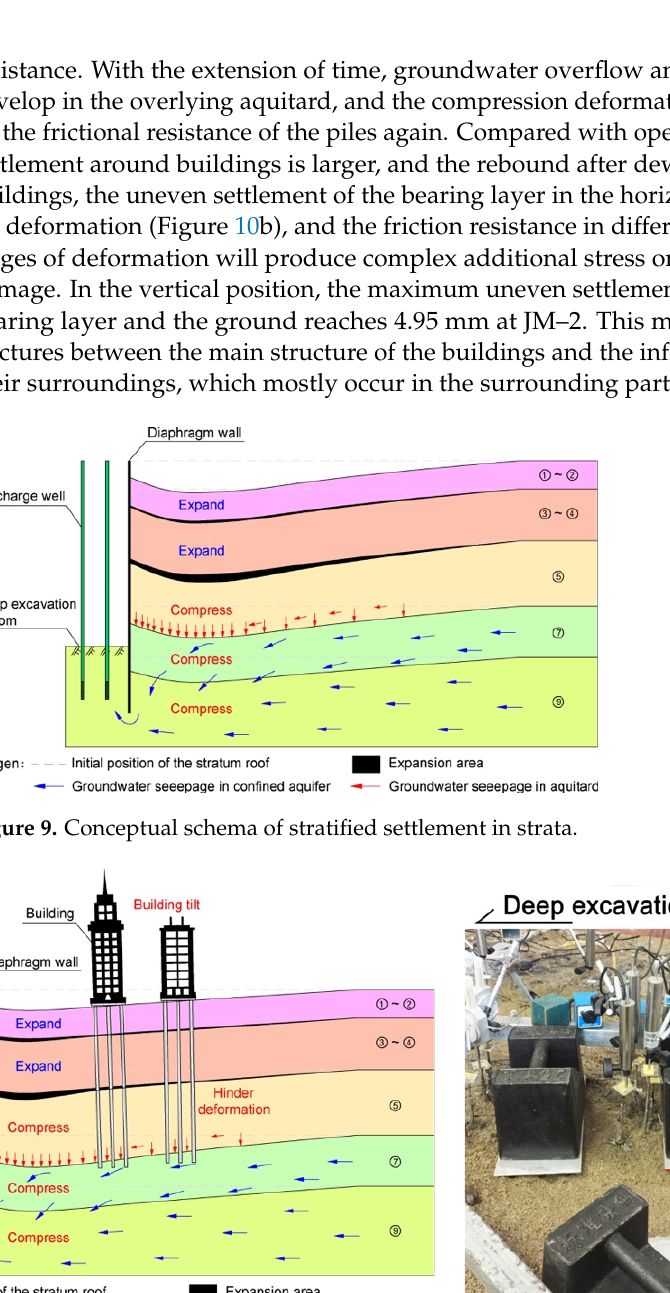
Figure 11. Conceptual schema of stratified settlement in strata around the tunnel. 6. Conclusions In this study, a physical model test was conducted to examine the law of stratified settlement in MAMA. A similar material was developed, which achieved deformation and seepage similar to real conditions. Buildings and a tunnel were added inside the physical model to analyze the impact of environmental conditions on the stratified settlement in MAMA. The following conclusions were obtained: